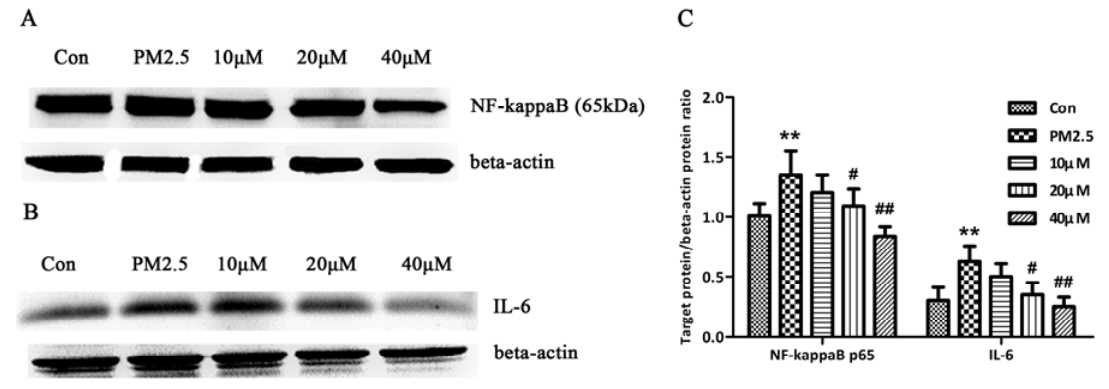
Figure 6. The effect of curcumin on the NF-kappaB p65 and IL-6 of 16HBE exposed to PM . 2.5 Cells were pre − treated with 10, 20, 40 μ M curcumin for 30 min followed by exposure to PM 2.5 (250 μ g/mL) for 24 h in the presence or absence of curcumin. After 24 h, cells were collected and measured for NF-kappaB p65 and IL-6 expression by Western blot. ( A ) Expression of NF-kappaB p65. ( B ) Expression of IL-6. ( C ) Bar graphs showing the quantification of Western blot bands. Beta-actin was used as an internal control. ** p < 0.01, compared with the control ## p < 0.01, compared with the PM group, # p < 0.05, 2.5